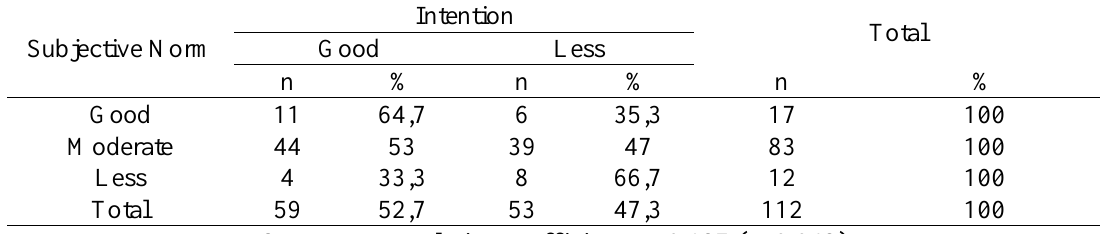
Cross Tabulation between subjective norm and intention In Implementation of Diabetes Mellitus Education Based on Theory of Planned Behavior in Public health center around Surabaya in